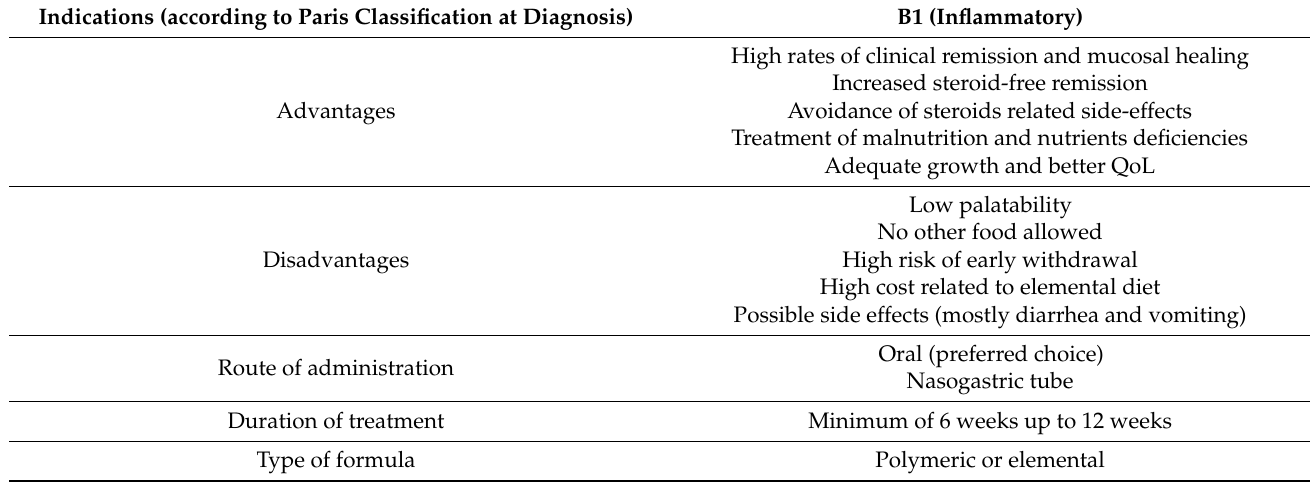
Table 1. Summary of EEN